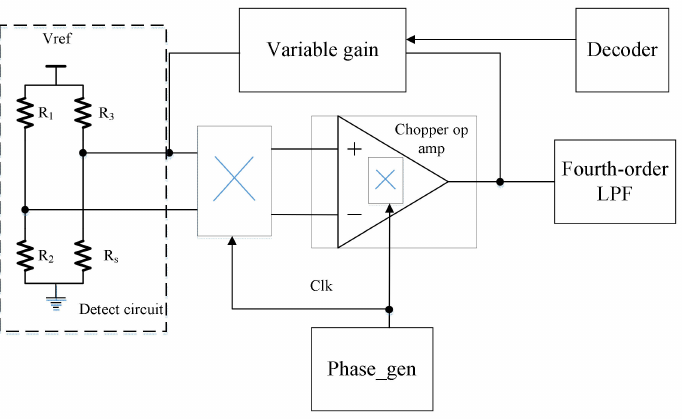
Figure 2. The basic structure of the previous circuit.